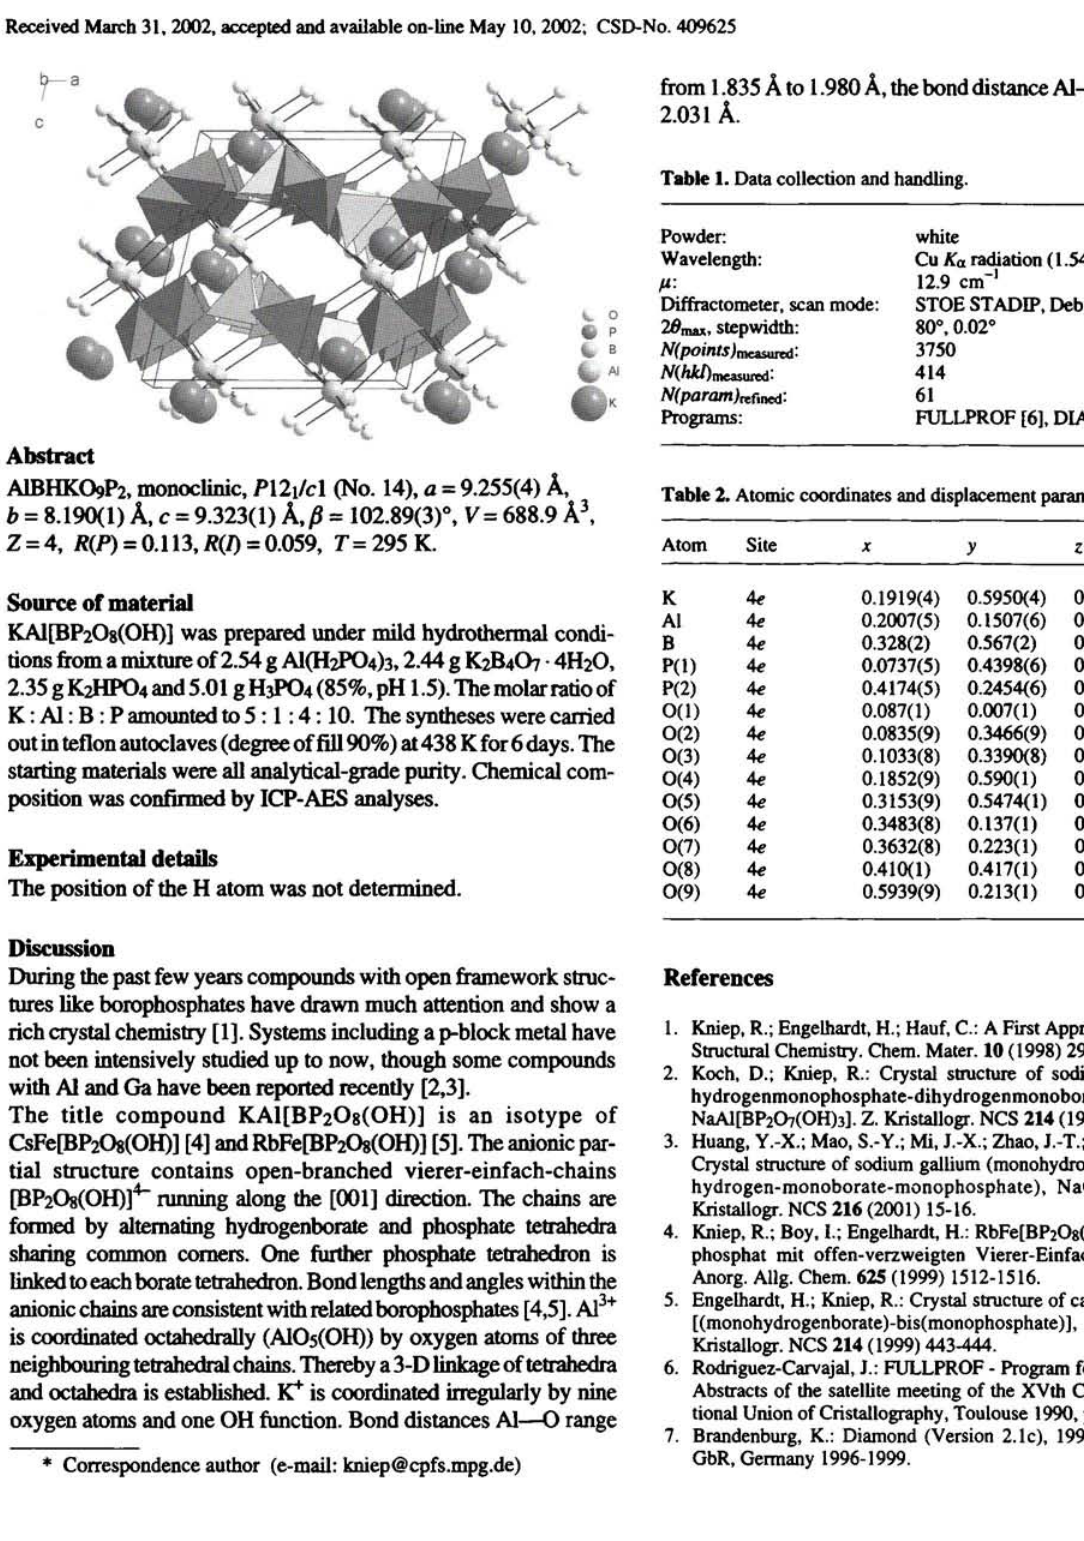
Table 1. Data collection and handling.